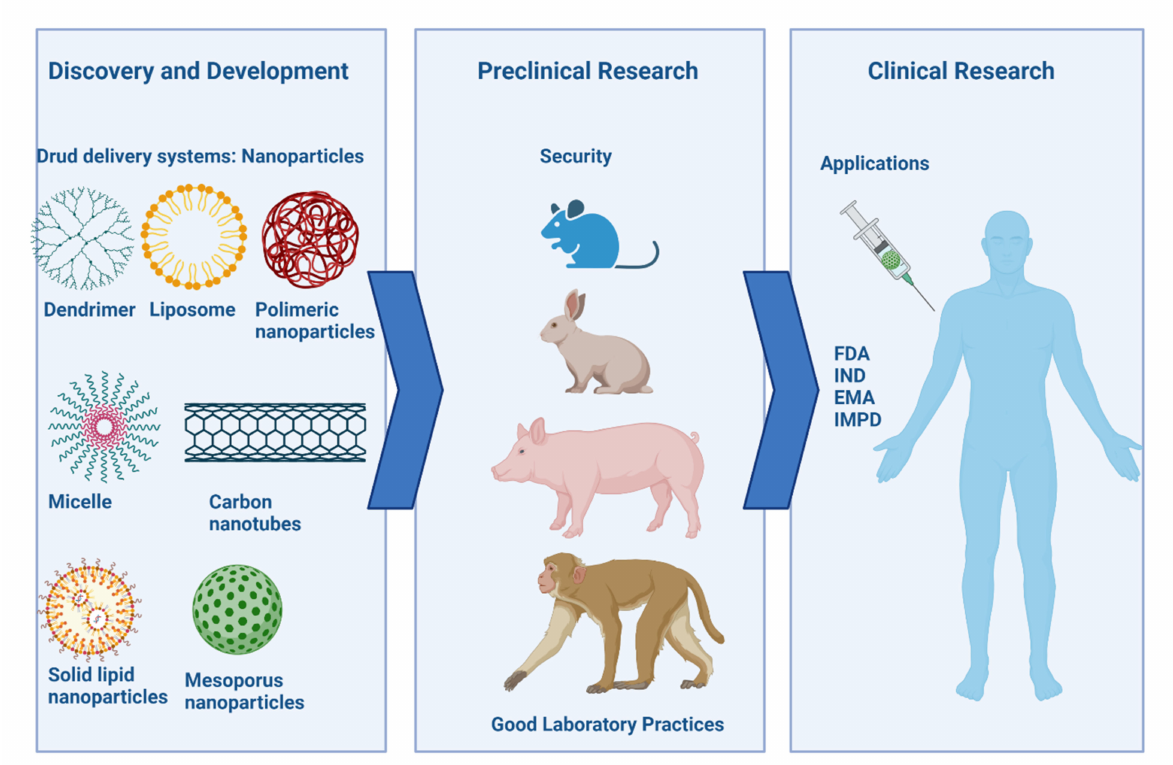
Figure 8. Characterization of preclinical studies for NPs in biomedicine. The common goal of preclin- ical studies is to identify potential immunological responses or other toxicities that can cause organ or system damage prior to administration in humans. The likelihood of characterizing NP toxicity increases as the formulation process advances from in vitro studies to preclinical in vivo models and clinical phases. In vivo toxicology studies include analysis of lymphoid organ weights, histological evaluation of immune organs and tissues, and understanding clinical chemistry parameters and hematology in two animal species: rodents and non-rodents (higher organisms). In addition,